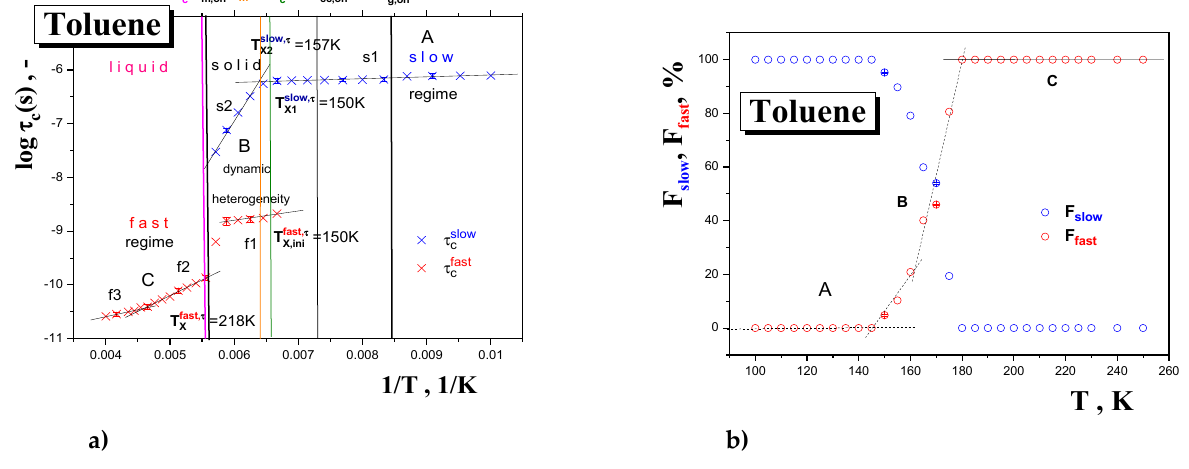
Figure 9. Arrhenius pot of the correlation time for the spin system TOL/TEMPO ( a ) and relative fraction of slow and fast spectral component as a function of temperature ( b ) as obtained via the NLSL program. Arrhenius equation fitting is as follows: slow region 1: τ 01slow =(3.5 ± 0.1) × 10 − 7 s, E 1slow = 0.35 ± 0.01 kJ/mol, r = 0.938; slow region 2: τ 02slow = (3.6 ± 0.05) × 10 − 19 s, E 2slow = 18.5 ± 0.01 kJ/mol, r = 0.995; fast region 1: τ 01fast = (1.6 ± 0.06) × 10 − 10 s, E 1fast = 1.6 ± 0.04 kJ/mol, r = 0.929; fast region 2: τ 02fast = (7.2 ± 0.02) × 10 − 14 s, E 2fast = 5.7 ± 0.13 kJ/mol, r = 0.998; fast region 3: τ 03fast = (2.9 ± 0.1) × 10 − 12 s, E 3fast = 2.3 ± 0.06 kJ/mol, r = 0.999.